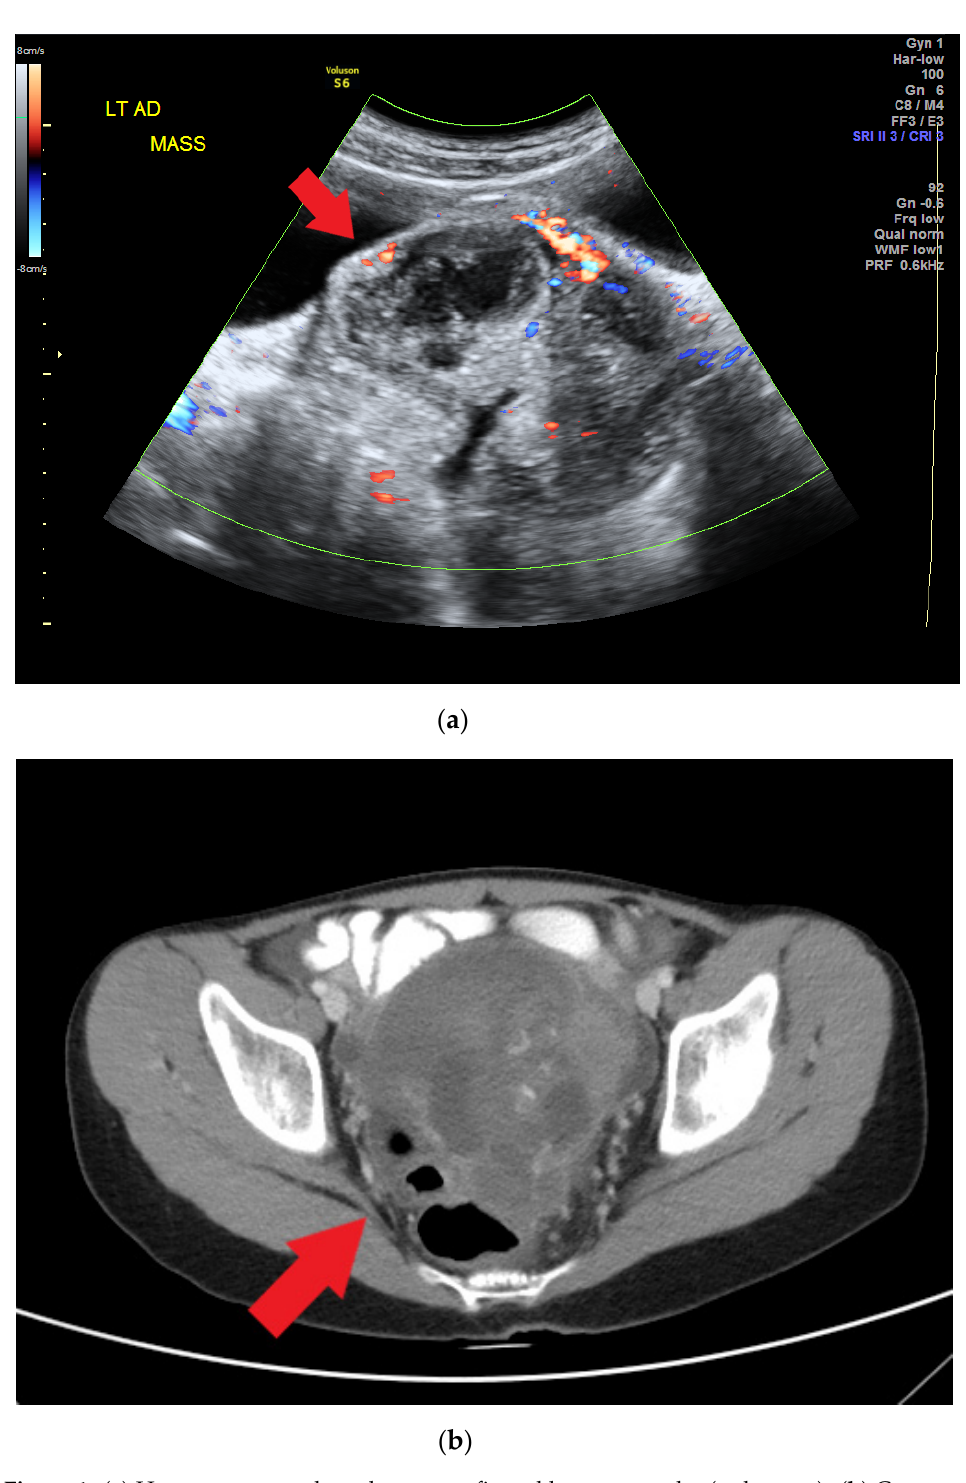
Figure 1. ( a ) Heterogeneous adnexal mass confirmed by sonography (red arrow). ( b ) Computed tomography scan revealing a lobulated mass lesion (maximum diameter of 10.1 cm) with cystic and solid components in the pelvis (red arrow).